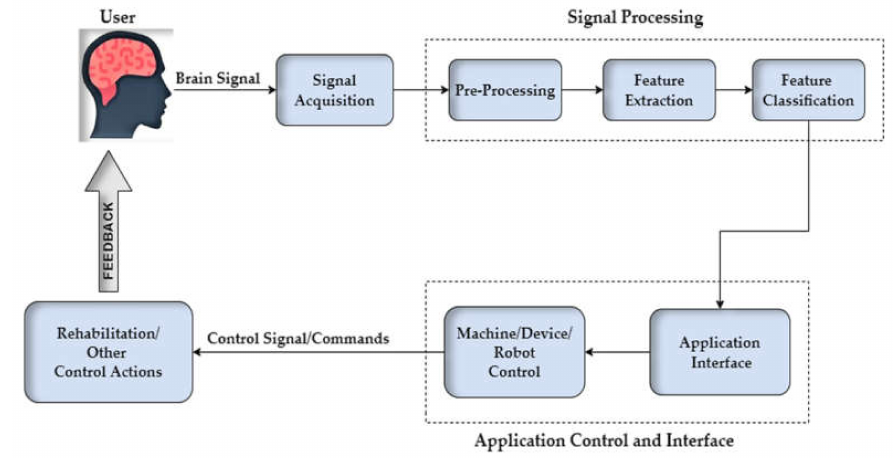
Figure 1. Basic design and operation of the brain-computer interface (BCI)-based